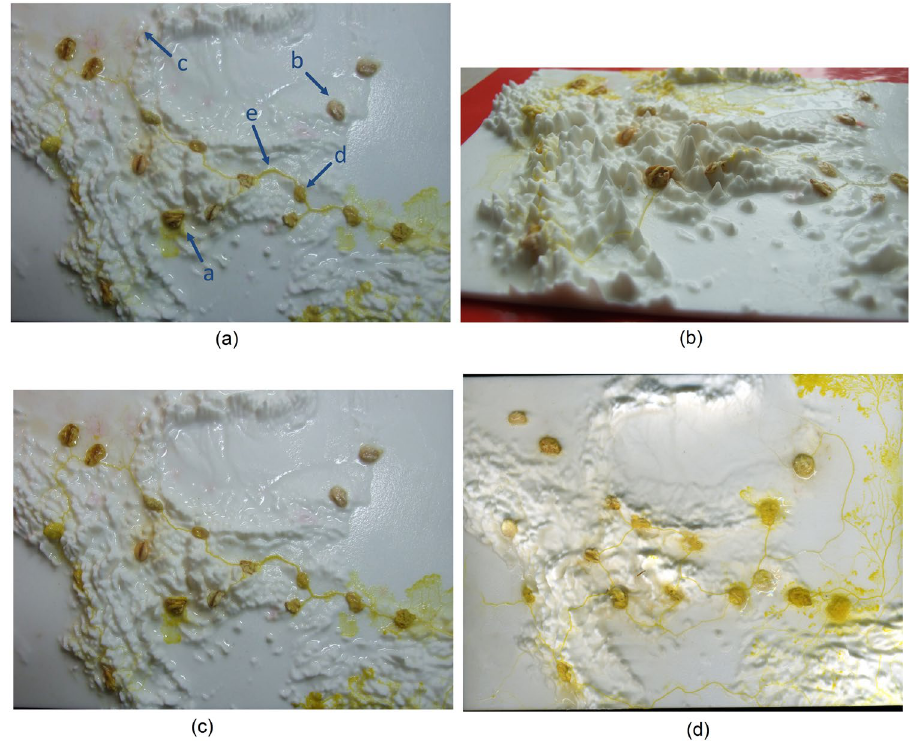
Figure 3. Experimental laboratory results. ( a ) A typical image of Physarum polycephalum growing on a non-nutrient substrate and connecting oat flakes, which represent major settlement areas U by a network of protoplasmic tubes, where a: site of inoculation, ( b ) oat flakes, ( c ) active zone, propagating in a search for nutrients, ( d ) oat flake occupied by Plasmodium, ( e ) protoplasmic tube. (Balkans territory template (Terrai): Physarum polycephalum growing in the 3D Balkans template and depictured in angular view. ( c and d ) Experimental laboratory example of north-east and then west propagation of the slime mould. Petri dishes with slime mould were scanned every 24